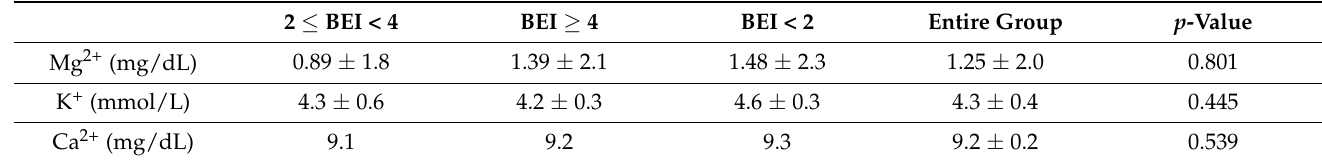
Table 3. Ambulatory BP characteristics of the entire study group and the subgroups. Mg 2+ , magnesium; K + , potassium; Ca 2+ , calcium; BEI, bruxism episode index. The mean 24-h SBP was 109.86 ± 7.3 mm Hg, and the mean DBP was 68.26 ± 5.5 mm Hg in the entire study group. No statistically significant differences were observed between the various parameters of BP in mild (2 ≤ BEI < 4) and severe bruxers (BEI ≥ 4) compared to the controls. The various parameters of BP are presented in Table 3. A statistically significant positive linear correlation was found between sodium con- centration and daytime SBP variability (r = 0.32, p < 0.05) as well as between sodium concentration and nighttime DBP variability (r = 0.31, p < 0.05). The correlations between blood pressure parameters and the concentration of sodium are presented in Figure